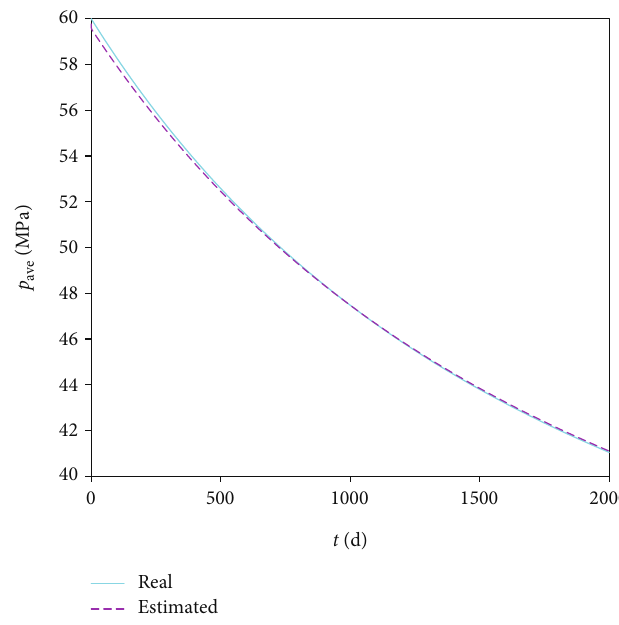
Figure 9: The real and estimated pro fi les of average reservoir pressure for the constant BHP gas